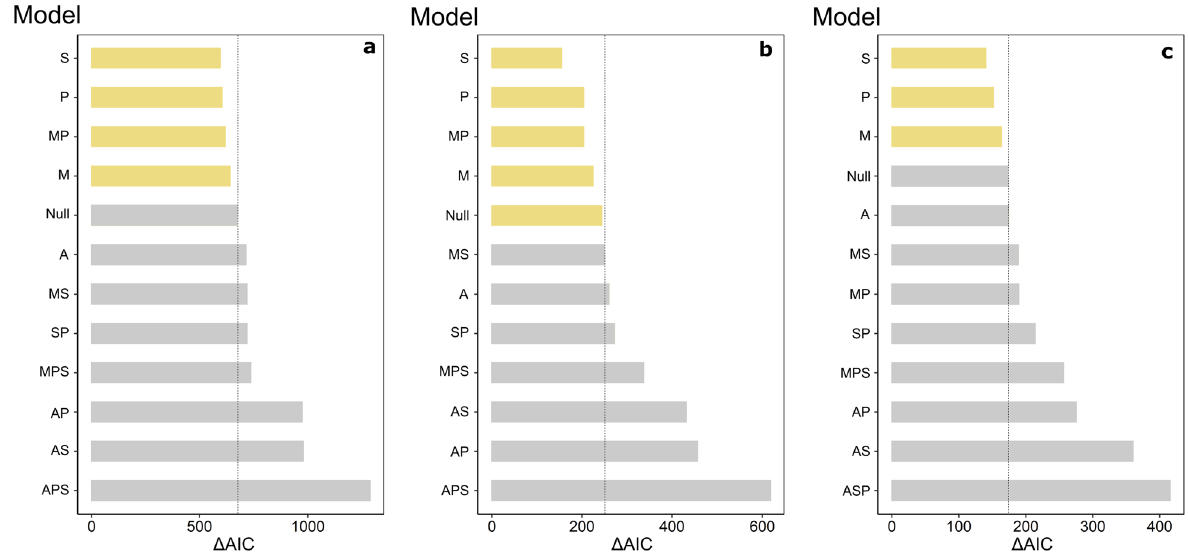
Figure 4. The likelihood of different interaction probability models of explaining pairwise interaction frequencies in the observed network. Model fit is expressed in their variation in the Akaike Information Criterion relative to the observed matrix. Models are organized from best fit (top) to worst fit (bottom). ( a ) Full network, ( b ) nectarivores only, and ( c ) other guilds only. Model labels—M: morphological specialization, A: relative abundance, S: spatial overlap, P: phenological overlap, Null: benchmark null